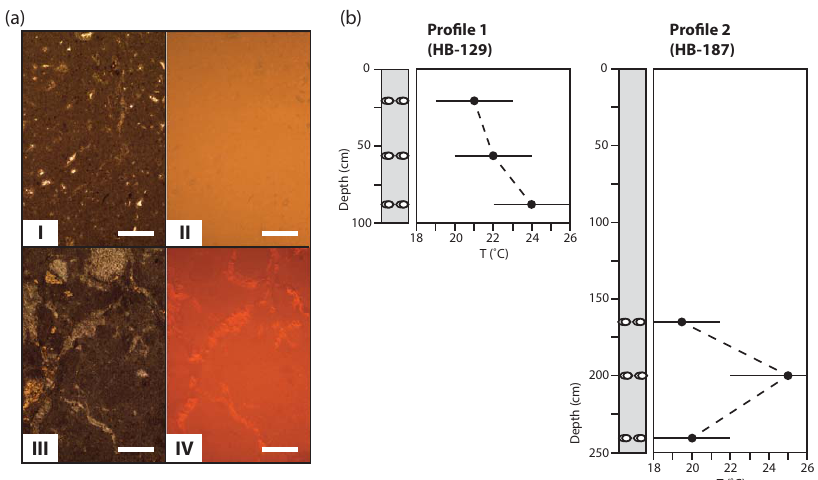
Figure 2. Paleosol carbonate descriptions. (a) Paired transmitted light and cathodoluminescence (CL) images of carbonate nodules showing primary micrite in sampled nodules (I–II) and diagenetically altered material in unsampled nodules (III–IV). Images taken on a Premier ELM-3R luminoscope at 8–10kV, 0.5mA, and 6.6–13.3Pa with preset 1s exposure; scale bars ∼ 50µm. (b) Clumped isotope-based soil temperature profiles from discrete layers sampled within analyzed paleosol exemplars. Profile HB-129 contained nodular carbonate layers